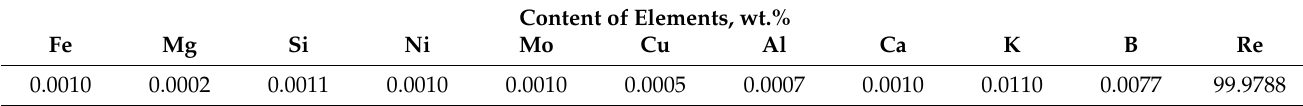
Figure 10. Distribution map Re ( A ); the result of EDX analysis ( B ). Table 1. Content of elements in the obtained deposits. Content of Elements, wt.%